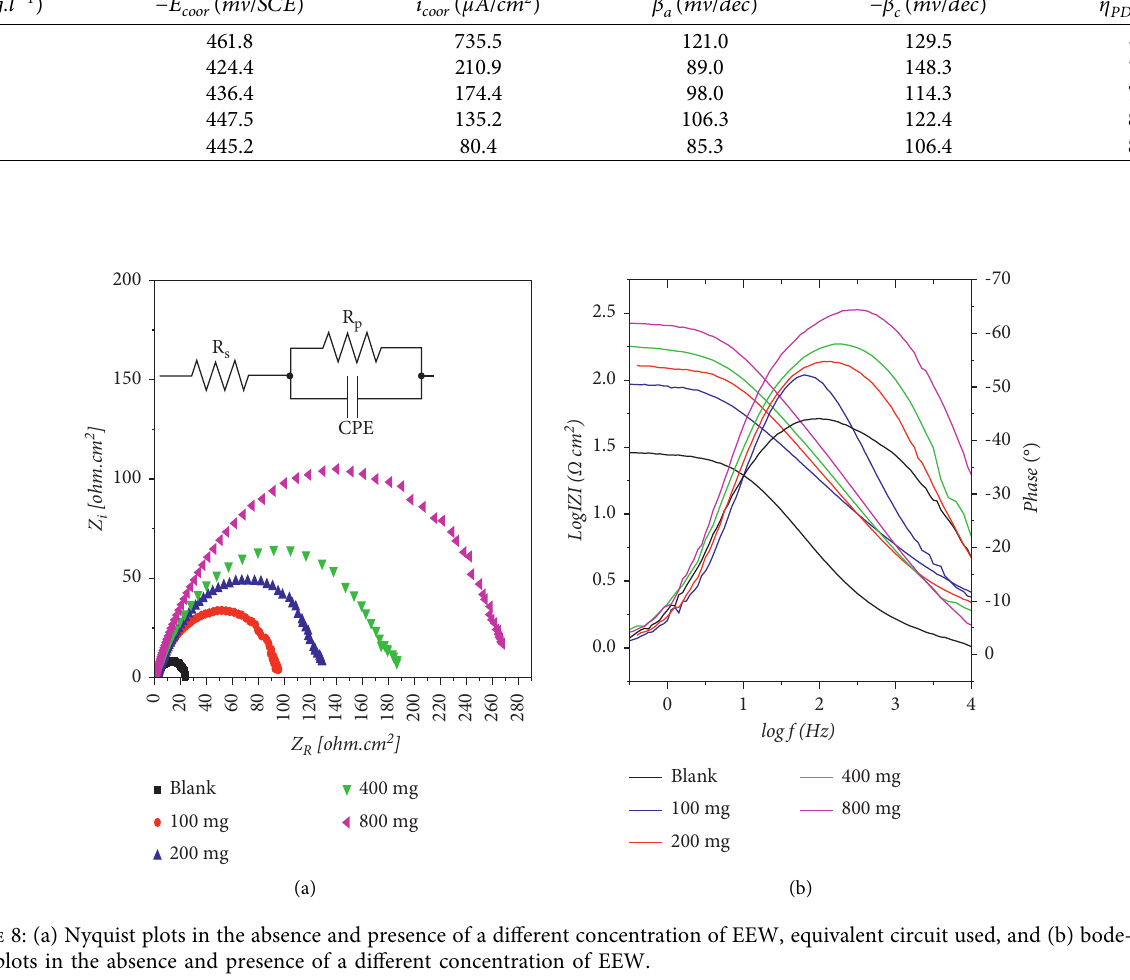
Table 6: Potentiodynamic polarization results for carbon-steel in 1M HCL, without and with EEW at 298 K. C ( g.l − 1 ) inh